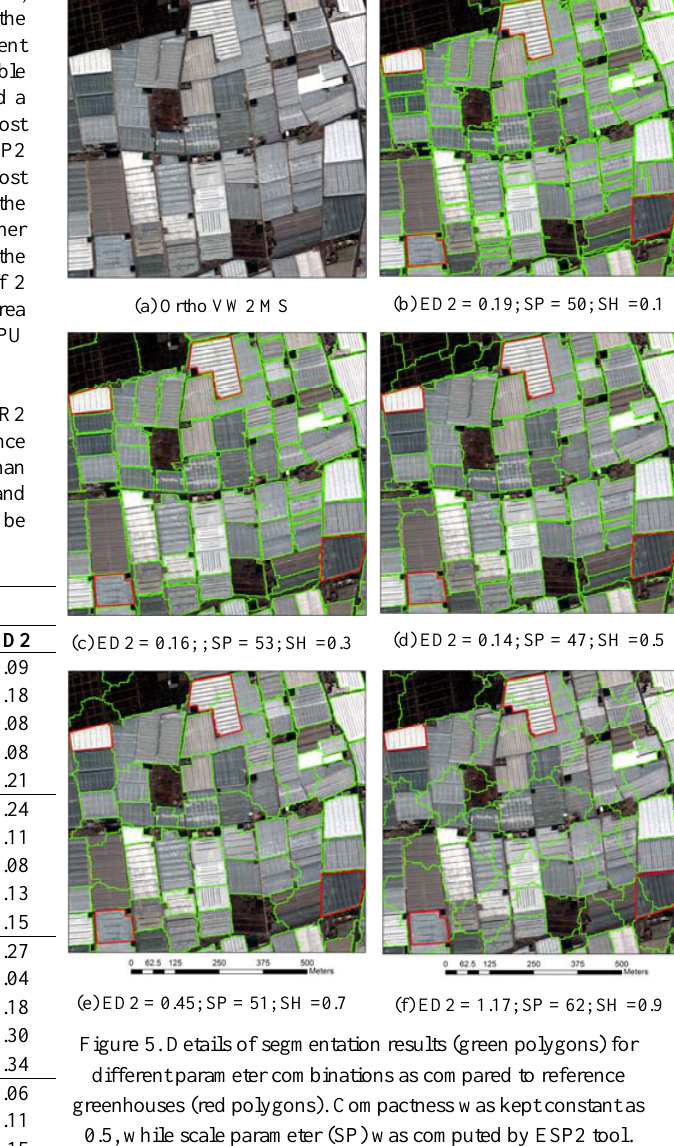
Figure 5. Details of segmentation results (green polygons) for different parameter combinations as compared to reference greenhouses (red polygons). Compactness was kept constant as 0.5, while scale parameter (SP) was computed by ESP2 tool. The Shape parameter took varying values (SH = 0.1, 0.3, 0.5, 0.7,